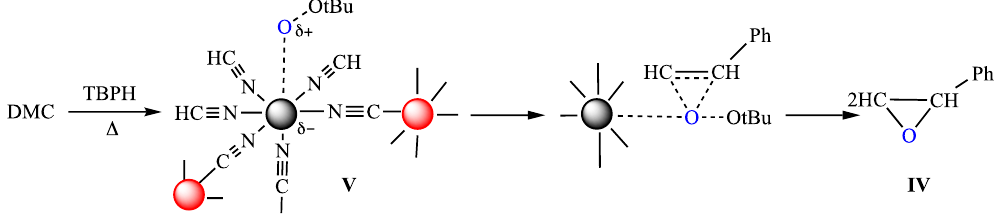
Scheme 3. Possible mechanism for the metal-hexacyanocobaltate with TBHP. The red spheres are inner Co bonded to C atoms, and the grey atoms are the outer metals bonded to N